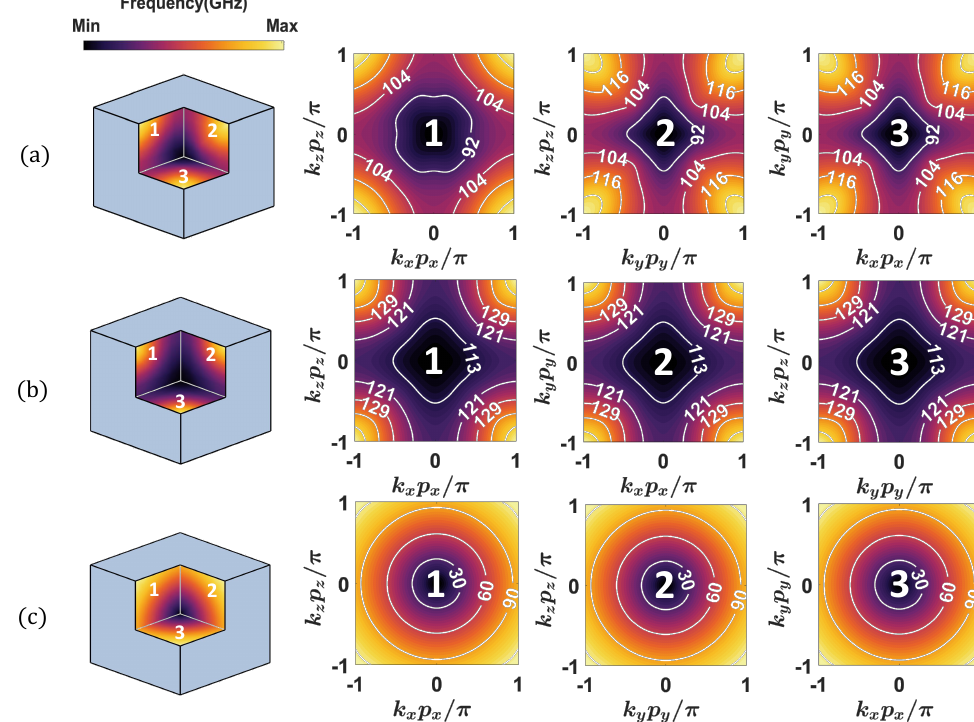
Figure 2. Dispersion analyses of: ( a ) single-wire unit cell; ( b ) twin-wire unit cell; ( c ) double-mesh twin-wire unit cell. The dimensions, as denoted in Figure1, are A = 0.1mm, N = 1, p = 1mm, and d =